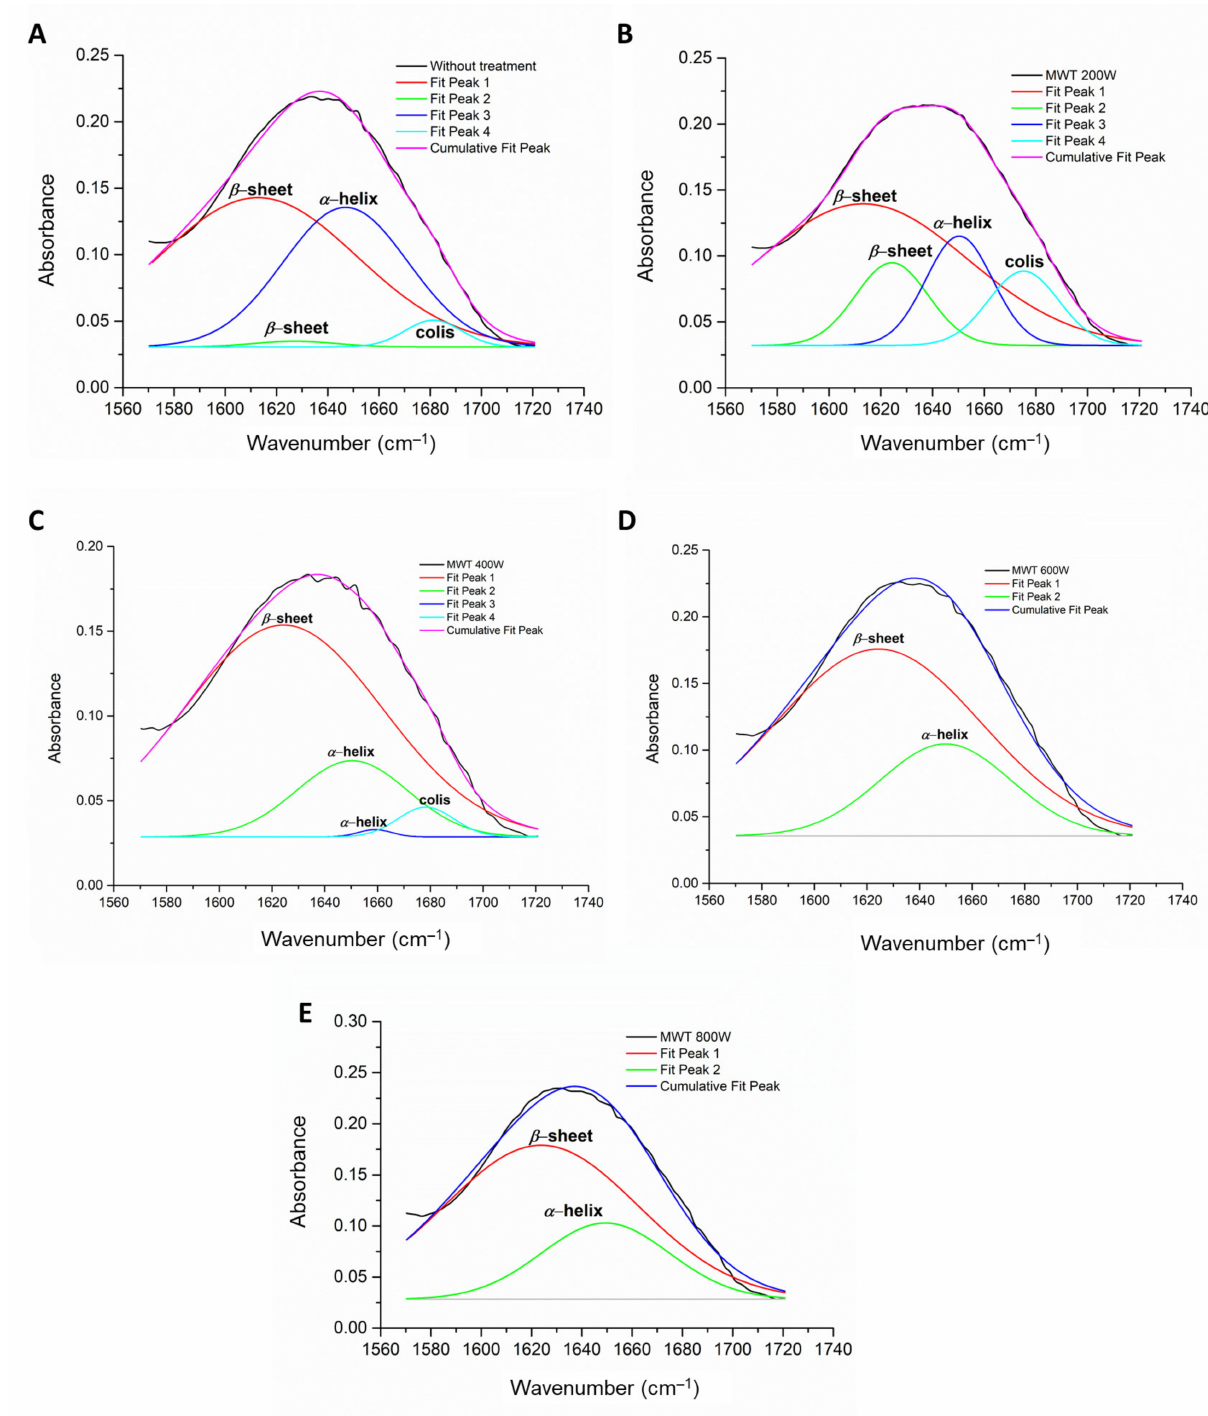
Figure 6. Peak deconvolution of Amide I band in the FTIR spectra of gluten proteins ( A ) without pretreatment and microwave pretreated at powers of ( B ) 200 W, ( C ) 400 W, ( D ) 600 W and ( E ) 800 W using Peak and Baseline functions (baseline subtracting, deconvolution, second derivate and Gaussian fitting mode) in the OriginPro Lab